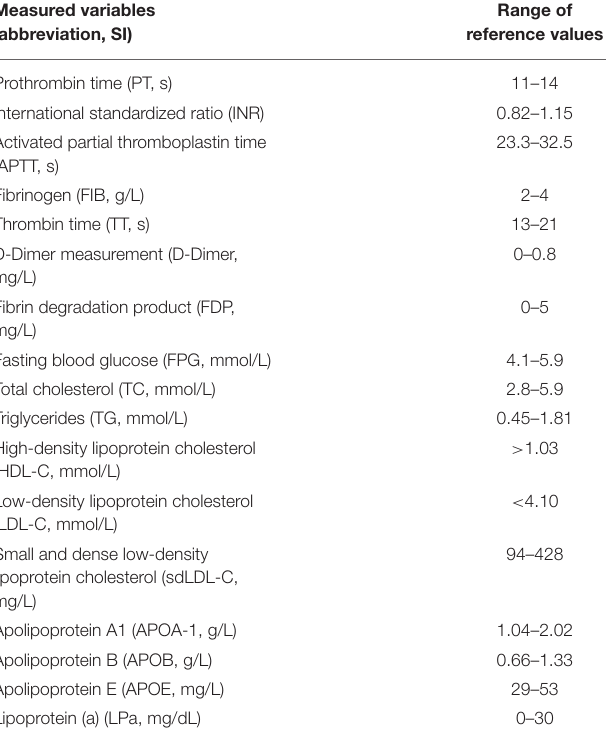
TABLE 1 | List of variables collected from coagulation function, fasting plasma glucose, blood lipid and lipoprotein profiles examinations. Measured variables (abbreviation, SI)